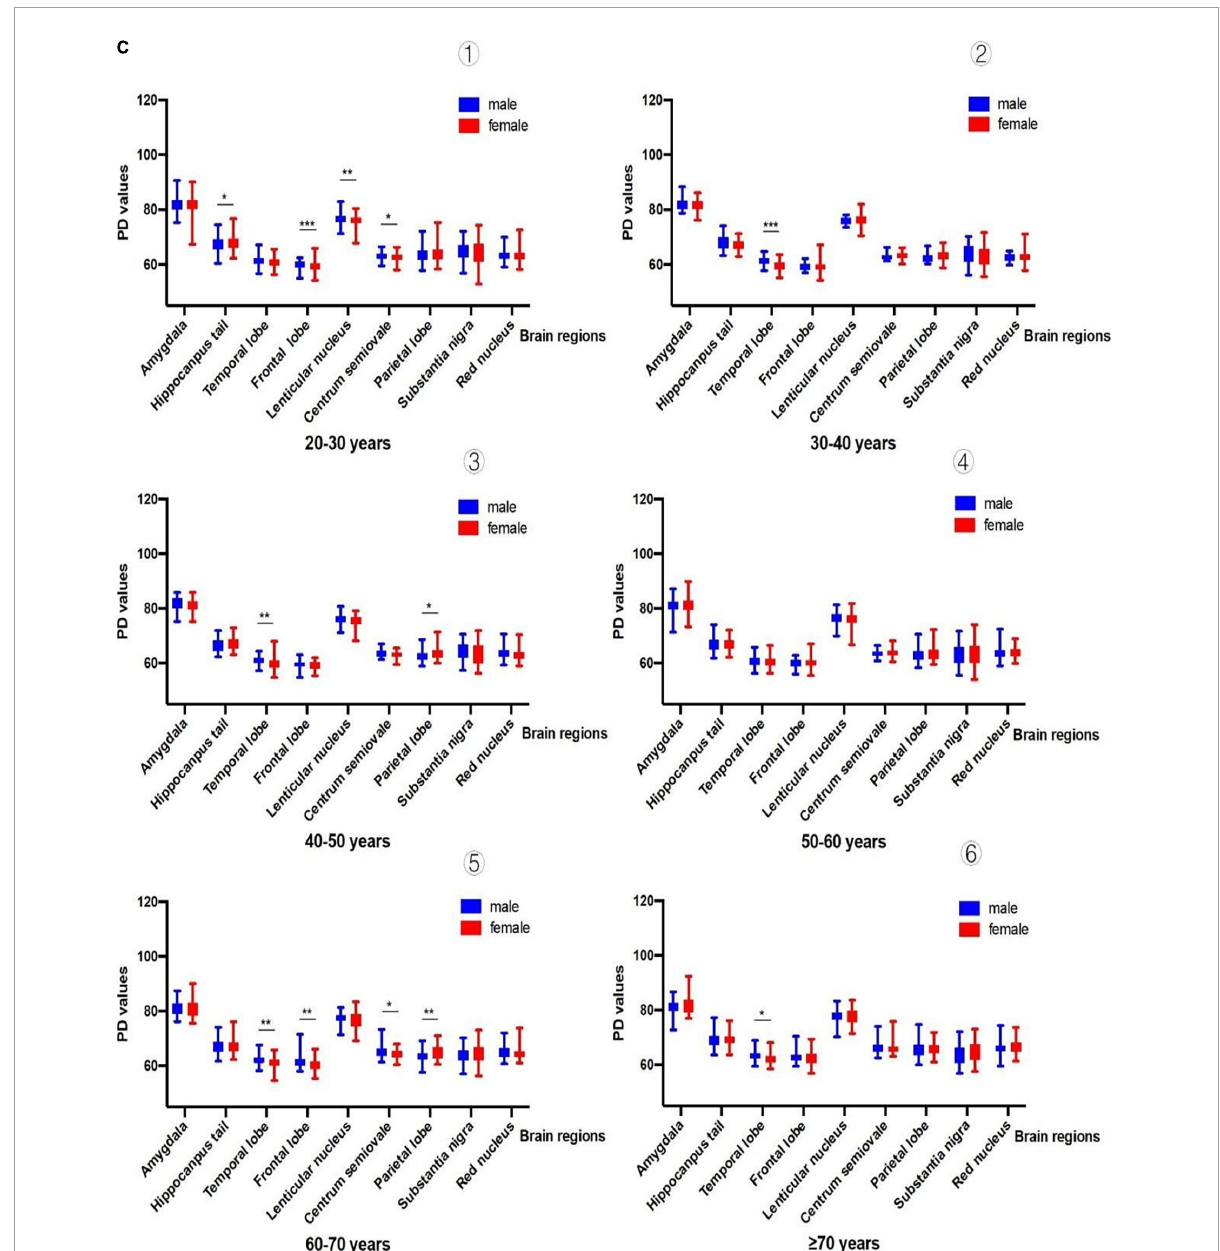
FIGURE3 (A) Comparison of T1 values among people of different sexes [ (cid:192) shows sex differences in T1 values (20-30 years): in the frontal lobe, caudate nucleus, lentiform nucleus, centrum semiovale and substantia nigra; (cid:193) shows sex differences in T1 values (30-40 years): only in the frontal lobe; (cid:194) shows sex differences in T1 values (40-50 years):only in the substantia nigra; (cid:195) shows sex differences in T1 values (50-60 years): only in the frontal lobe; (cid:196) shows sex differences in T1 values (60-70 years): only in the frontal lobe; (cid:197) shows sex differences in T1 values (70 years): only in the frontal lobe]. (Male vs. female, ∗ P<0.05; ∗∗ P<0.01; ∗∗∗ P<0.001). (B) Comparison of T2 values among people of different sexes [ (cid:192) shows sex differences in T2 values (20-30 years): in the caudate nucleus, lenticular nucleus, and parietal lobe; (cid:193) shows sex differences in T2 values (30-40 years):all brain regions had no significant difference; (cid:194) shows sex differences in T2 values (40-50 years): only in the hippocampal tail; (cid:195) shows sex differences in T2 values (50-60 years): only in the pons; (cid:196) shows sex differences in T2 values (60-70 years): all brain regions had no significant difference; (cid:197) shows sex differences in T2 values (70 years): all brain regions had no significant difference]. (Male vs. female, ∗ P<0.05; ∗∗ P<0.01; ∗∗∗ P<0.001). (C) Comparison of PD values among people of different sexes [ (cid:192) shows sex differences in PD values (20-30 years): in the hippocampal tail, frontal lobe, lentiform nucleus, and centrum semiovale; (cid:193) shows sex differences in PD values (30-40 years): only in the temporal lobe; (cid:194) shows sex differences in PD values (40-50 years): only in the temporal lobe and parietal lobe; (cid:195) shows sex differences in PD values (50-60 years): there was no significant difference in all brain regions; (cid:196) shows sex differences in PD values (60-70 years): in the temporal lobe, frontal lobe, centrum semiovale, and parietal lobe; (cid:197) shows sex differences in PD values (70 years): only in the temporal lobe]. (Male vs. female, ∗ P<0.05; ∗∗ P<0.01; ∗∗∗